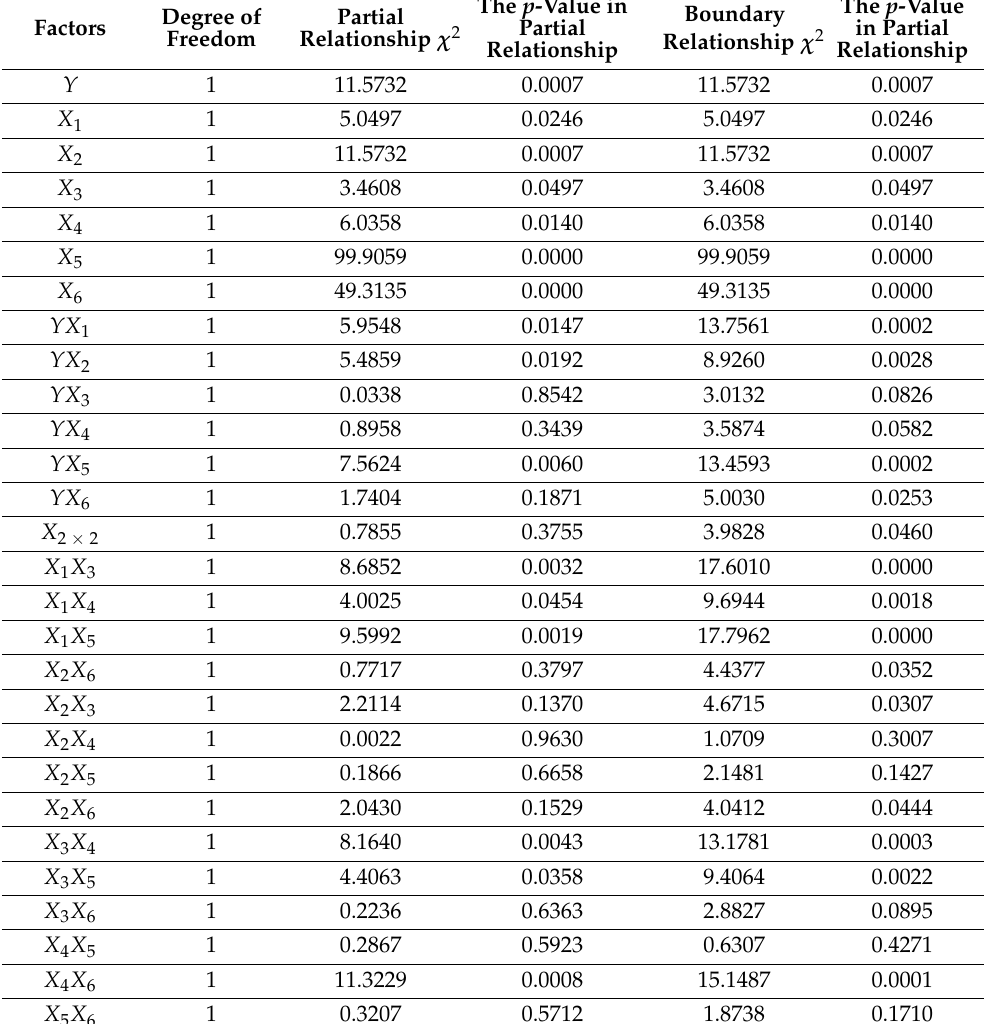
Table 7. Excerpts from the results of partial and boundary tests between variables: Y, X 1 , X 2 , X 3 X 4 , X 5 , X 6